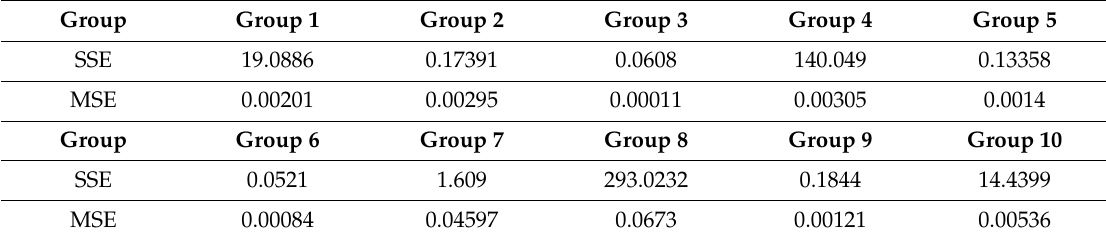
Table 5. Evaluation metrics of predict model for COP after clustering of each group.